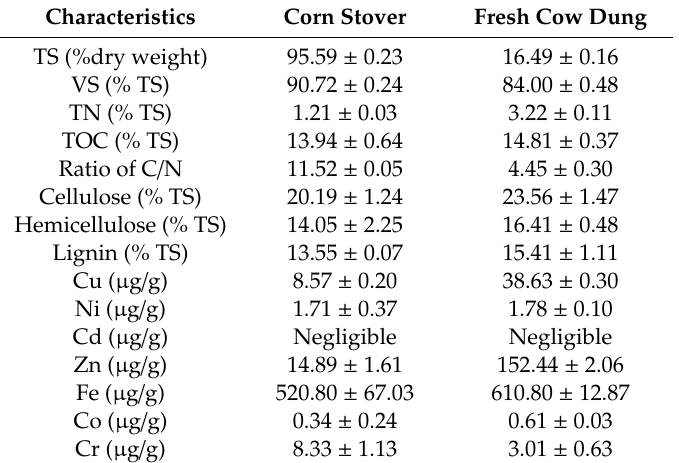
Table 2. Characteristics of corn stover and the cow dung. Characteristics Corn